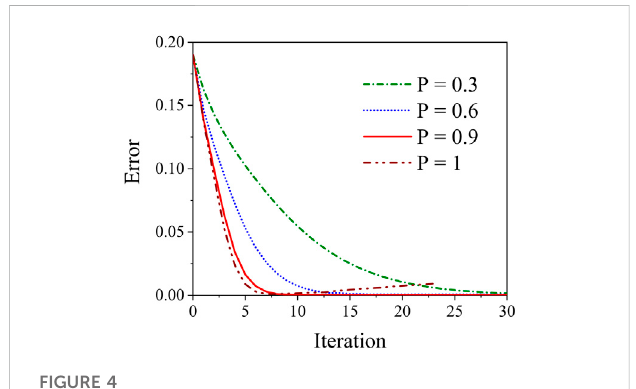
FIGURE 4 The relationship between output pulse distortion ratio and the calculation iteration with different parameter